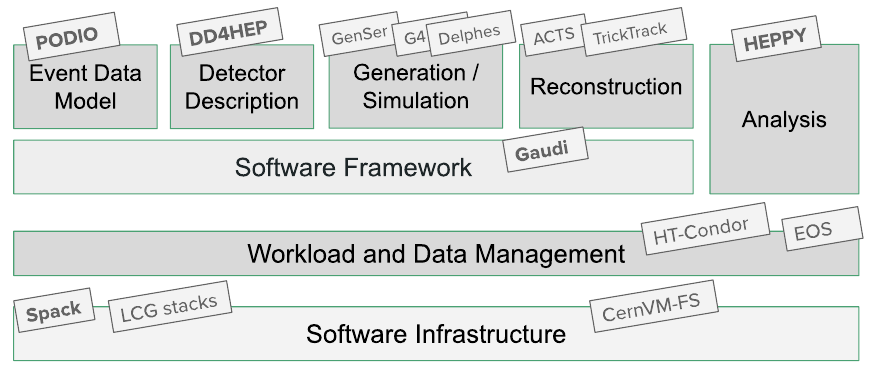
Figure 1. The components taken from existing projects included in FCCSW. See the text for a descrip- tion of their